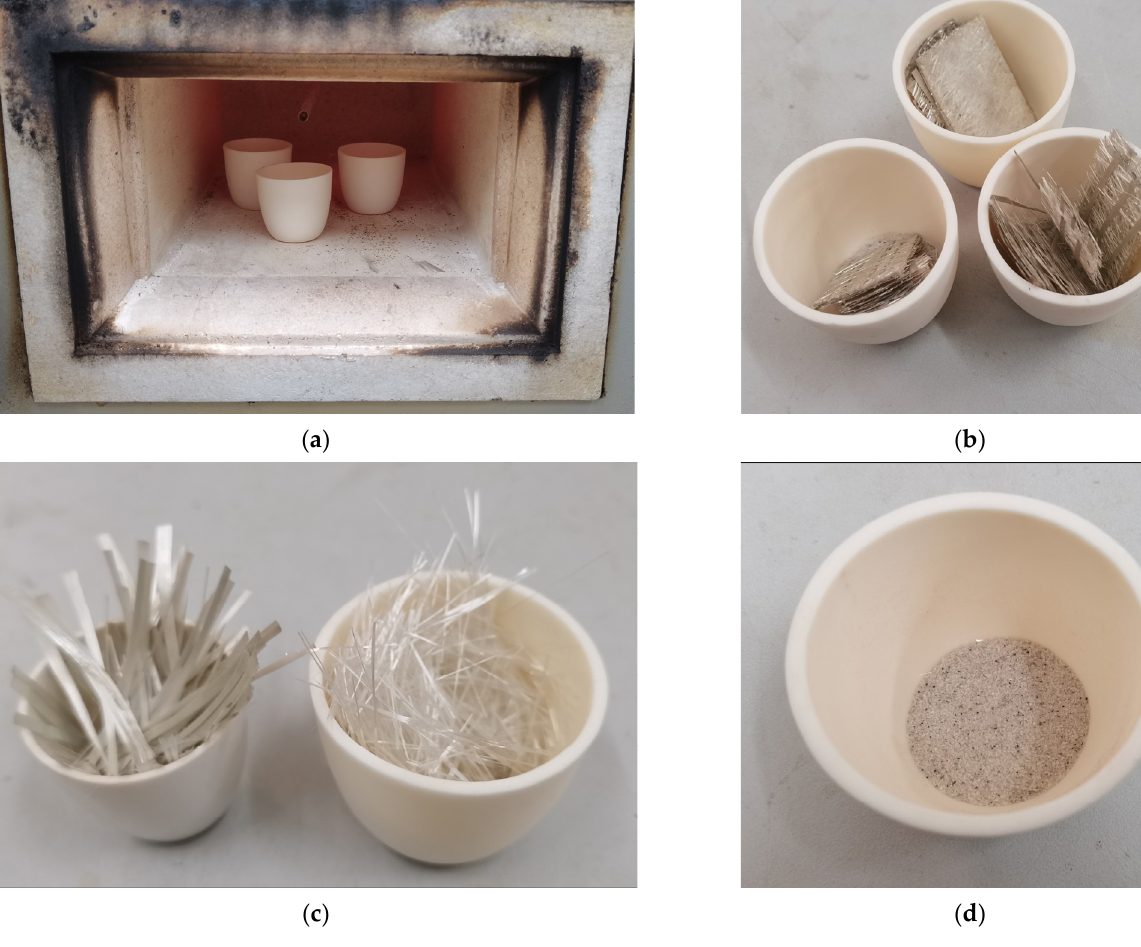
Figure 1. Diagram of the process of measuring the component content of GFRP pipes. ( a ) Thermal decomposition reactions of resins. ( b ) Measuring the content of resin. ( c ) Measuring the content of fiber. ( d ) Measuring the content of quartz sand.